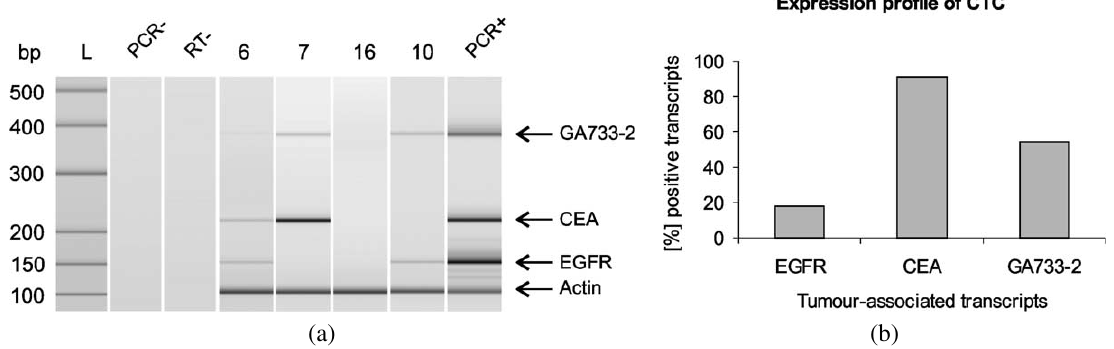
Fig. 1. Detection and expression profiling of CTC in blood of CRC patients by multiplex RT-PCR after immunomagnetic tumour cell enrichment. (a) Amplified cDNA fragments of tumour-associated transcripts GA733-2, CEA and EGFR and the internal control actin are shown. Fragments were analyzed by capillary electrophoresis with the Bioanalyzer 2100 (Agilent Technologies, Böblingen, Germany). bp: Base pairs; L: ladder; (–): negative control for PCR or RT; ( + ): positive control for PCR, numbers are patient IDs. (b) Percentage of the expression of tumour-associated transcripts in CTC positive